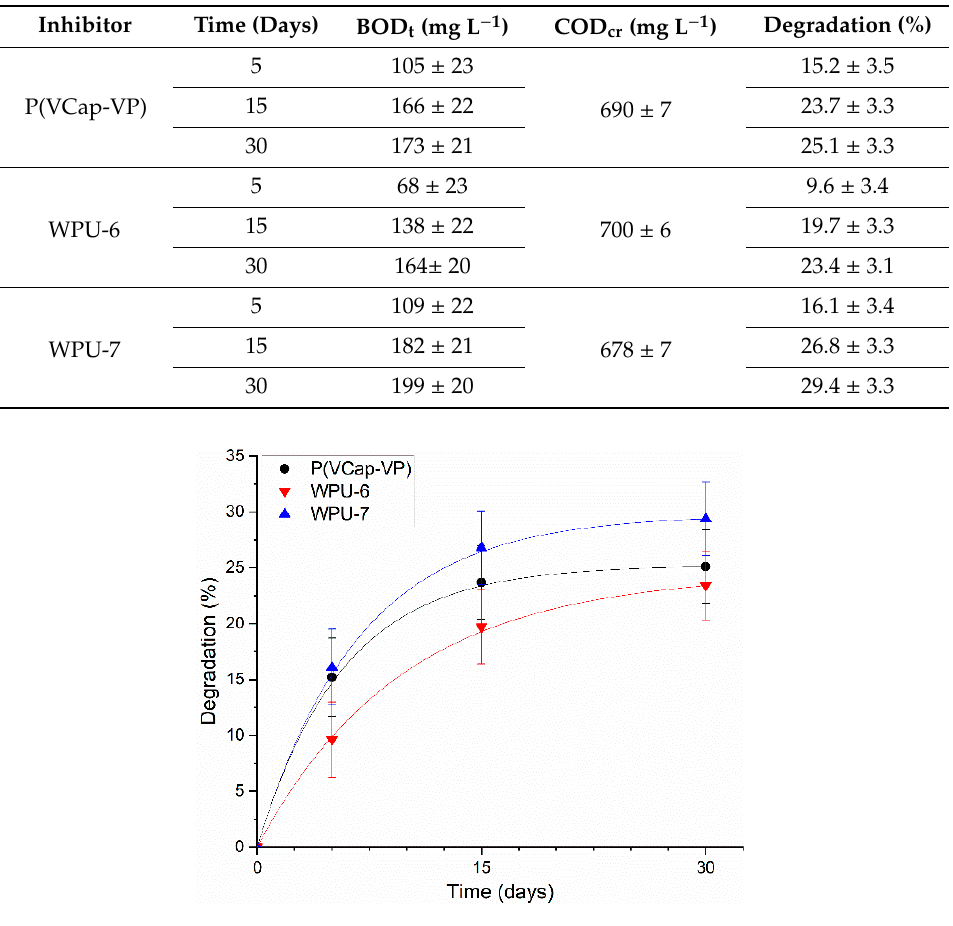
Figure 8. Biodegradation trends for WPU-6, WPU-7, and P(VCap-VP).